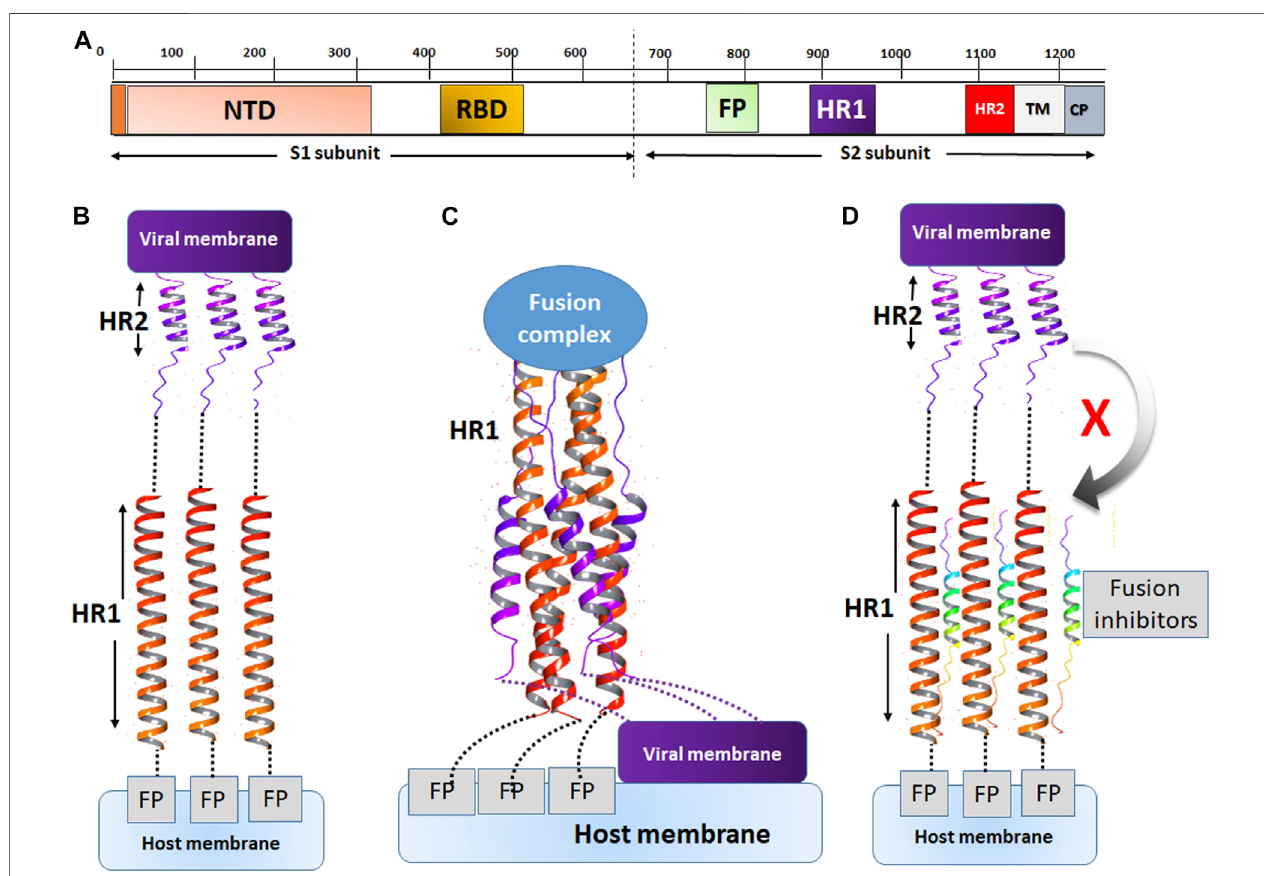
FIGURE 7 | The mechanism of action of fusion inhibitors. (A) The composition of MERS-CoV S protein. The S1 subunit contains the nucleotide binding domain (NBD)andthereceptorbindingdomain(RBD).TheS2subunitcontainsthefusionprotein(FP),HR1,HR2,thetransmembranedomain(TM)andthecytoplasmicdomain (CP). (B) The prefusion conformation. HR2 assists in the fusion between the viral and host cell membranes. (C) The conformation of fusion state. The viral and cell membranesmoveinclose positionand membrane fusionoccurs. (D) Thefusioninhibitor peptides bindtoHR2and preventtherecognitionofHR2ontoitsbinding sites on